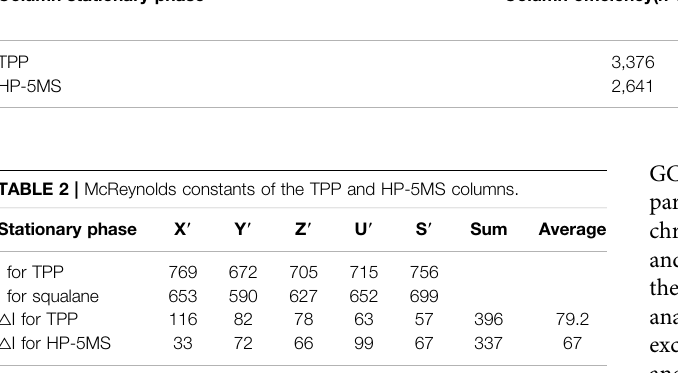
TABLE 1 | Column ef fi ciencies (plates/m) of the TPP and commercial columns. Column stationary phase